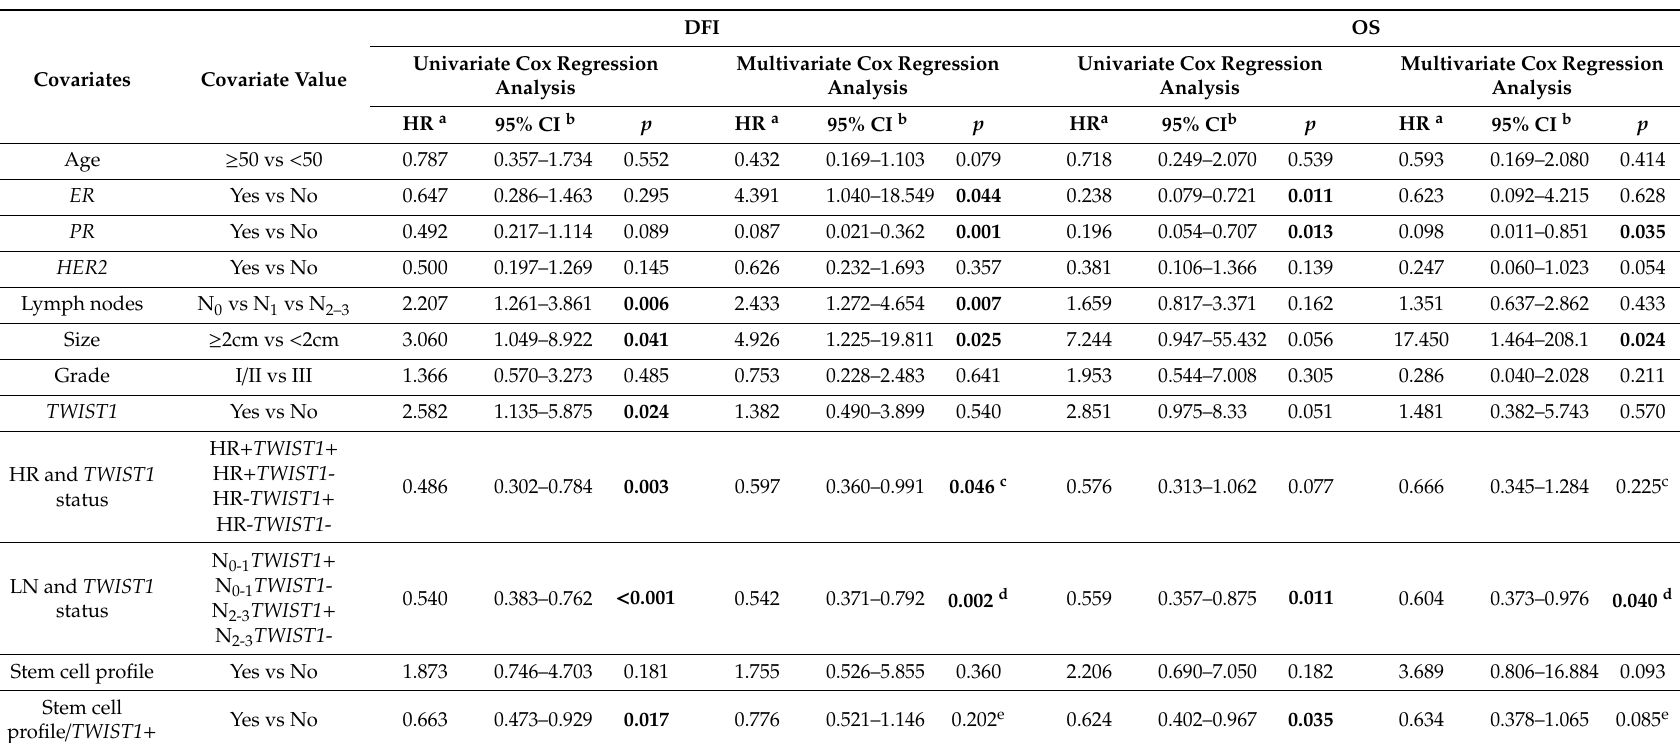
Table 3. Univariate and multivariate analyses for DFI and OS in the early breast cancer patients group ( n =